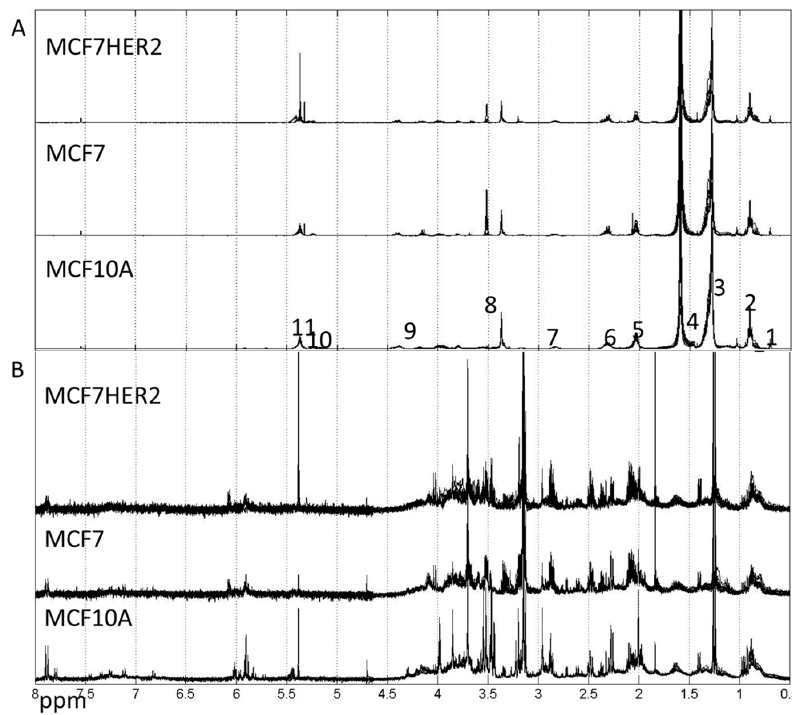
Figure 3. Spectra of lipophilic ( A ) and hydrophilic ( B ) metabolic extracts from MCF10A, MCF7 and MCF7HER2 cells incubated under different treatment conditions in different biological replicates measured here. (A) Labels correspond to peaks from: 1–CH3; 2–CH3 (L, Ch), CH2 (Ch); 3–CH2 (L, Ch); 4–CH2CH2COO (L) and H2O; 5–CH2CH=CH (L); 6–N(CH3); 7–Ar-H; 8–N(CH3)3; 9–CH2OCOR, CH2OPO2; 10–CHOCOR (lipids); 11–HC=CH (lipids, cholesterol). Assignment of peaks is based on [31]. (B) Hydrophilic spectra for the same three cell types. These spectra are representative of 3–5 independent experiments.